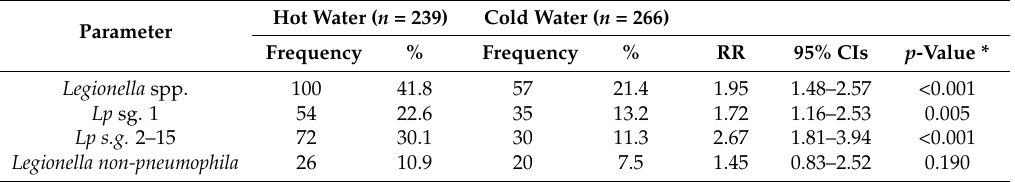
Table 2. Correlation between water temperature and Legionella detection. CIs—confidence intervals. Parameter Legionella spp .